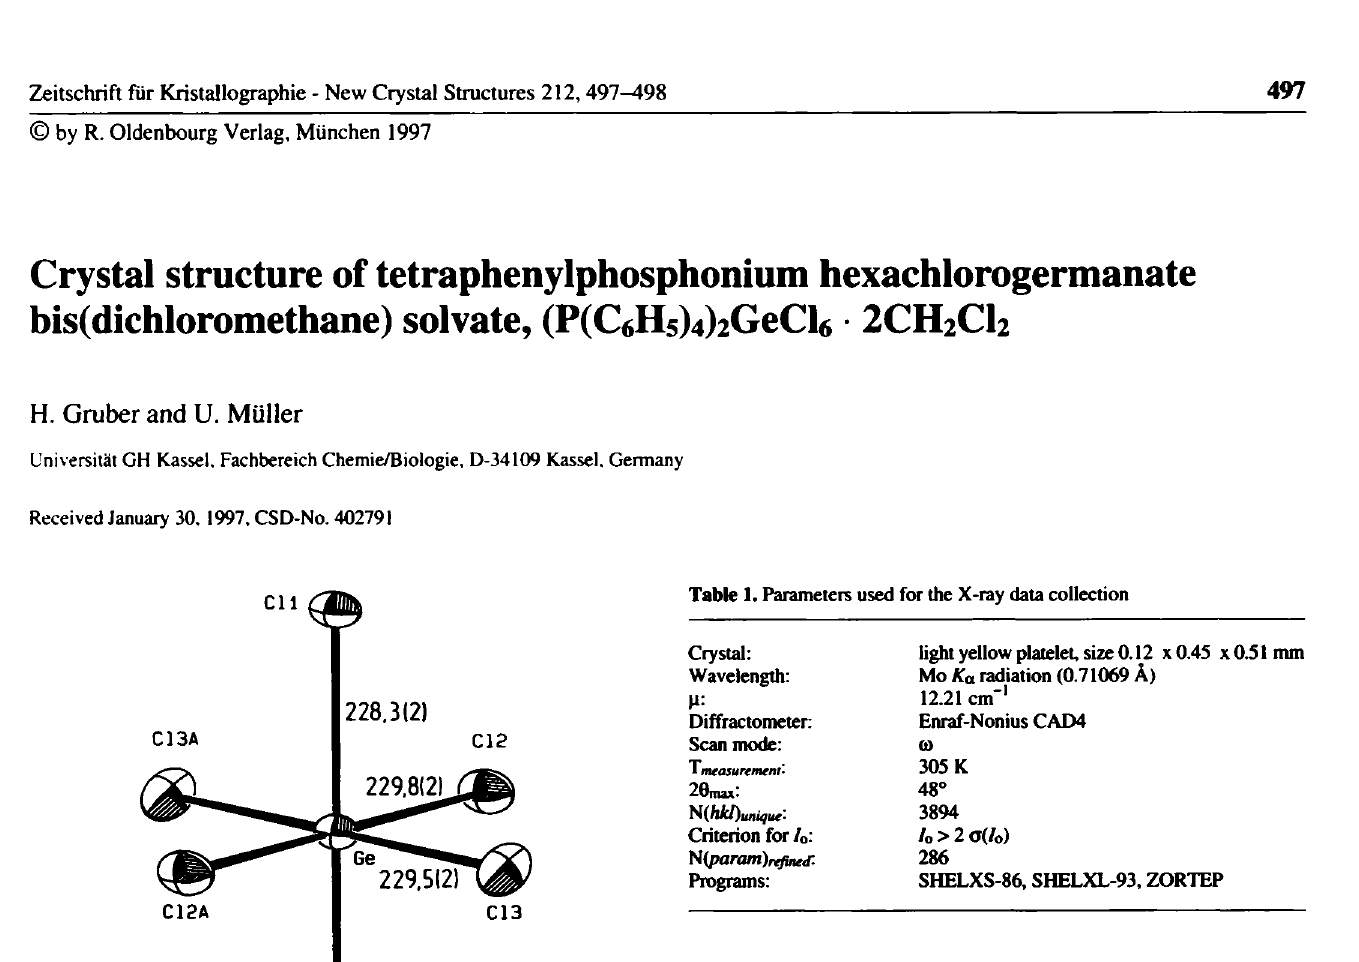
Table 2. Final atomic coordinates and displacement parameters (in Â 2 )